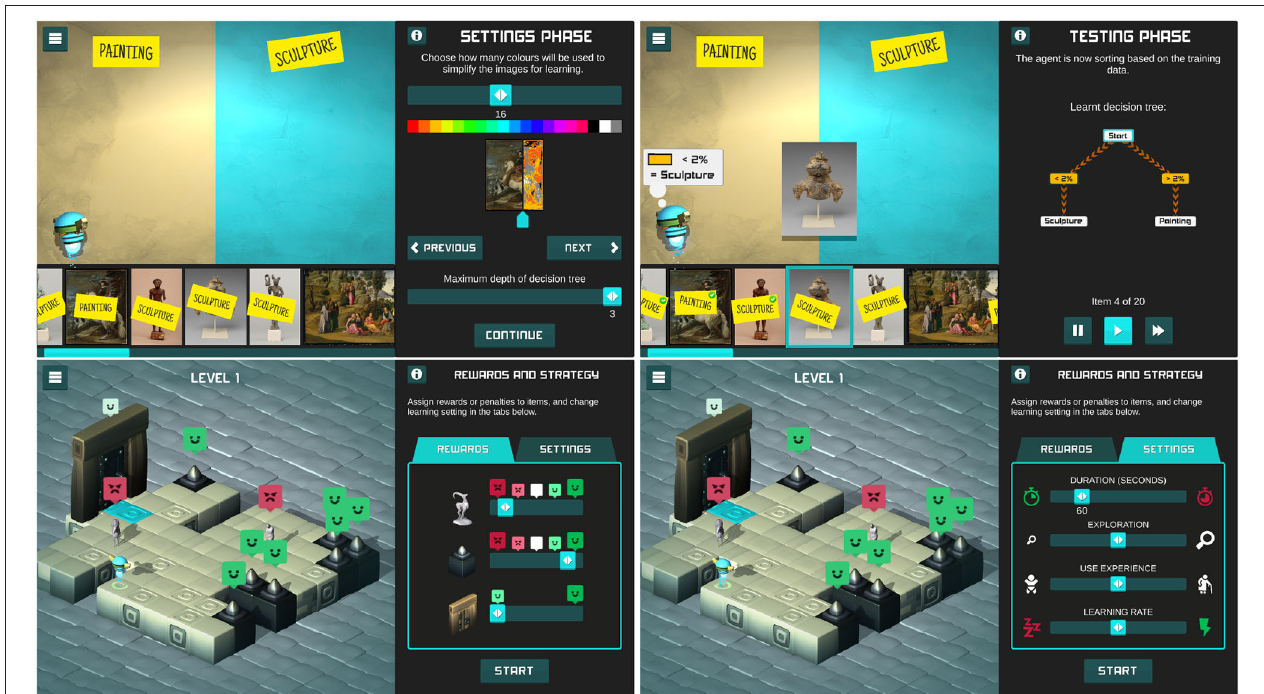
FIGURE 1 | Screenshots of ArtBot, showing (in order) the SL mini-game settings (top left) and the resulting classification (top right) screens. The RL mini-game offers two sets of settings to the players: rewards and penalties of the various objects (bottom left), and RL parameters (bottom right).